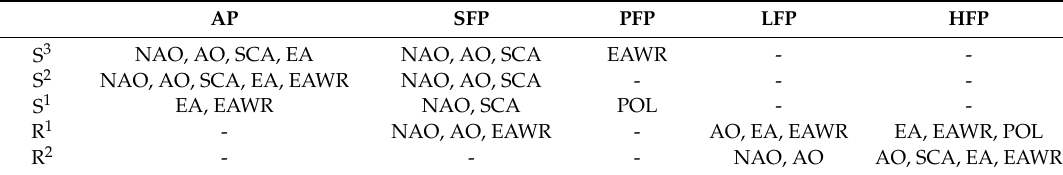
Table 3. The teleconnection patterns identified as the dominant drivers of the temporal variability in the different hydrological periods in the five homogeneous regions. The regions are divided into two groups, a northern group dominated by snow processes (S) and a southern group dominated by rain processes (R). The periods (AP, SFP, PFP, LFP, HFP) are defined in Figure 3. AP SFP PFP LFP HFP S 3 NAO, AO, SCA, EA NAO, AO, SCA EAWR - - S 2 NAO, AO, SCA, EA, EAWR NAO, AO, SCA - - - S 1 EA, EAWR NAO, SCA POL - - R 1 - NAO, AO, EAWR - AO, EA, EAWR EA, EAWR, POL R 2 - - - NAO, AO AO, SCA, EA,